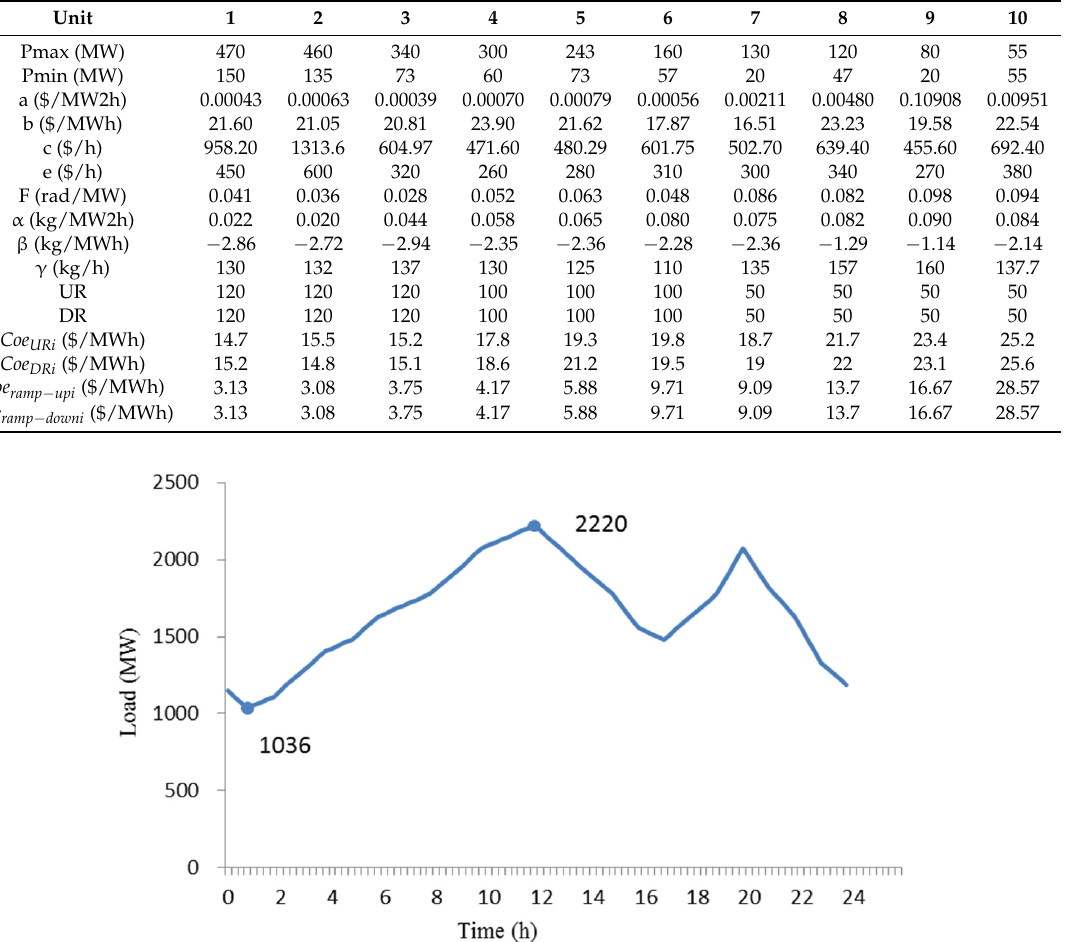
Figure 7. Daily load demand curve.